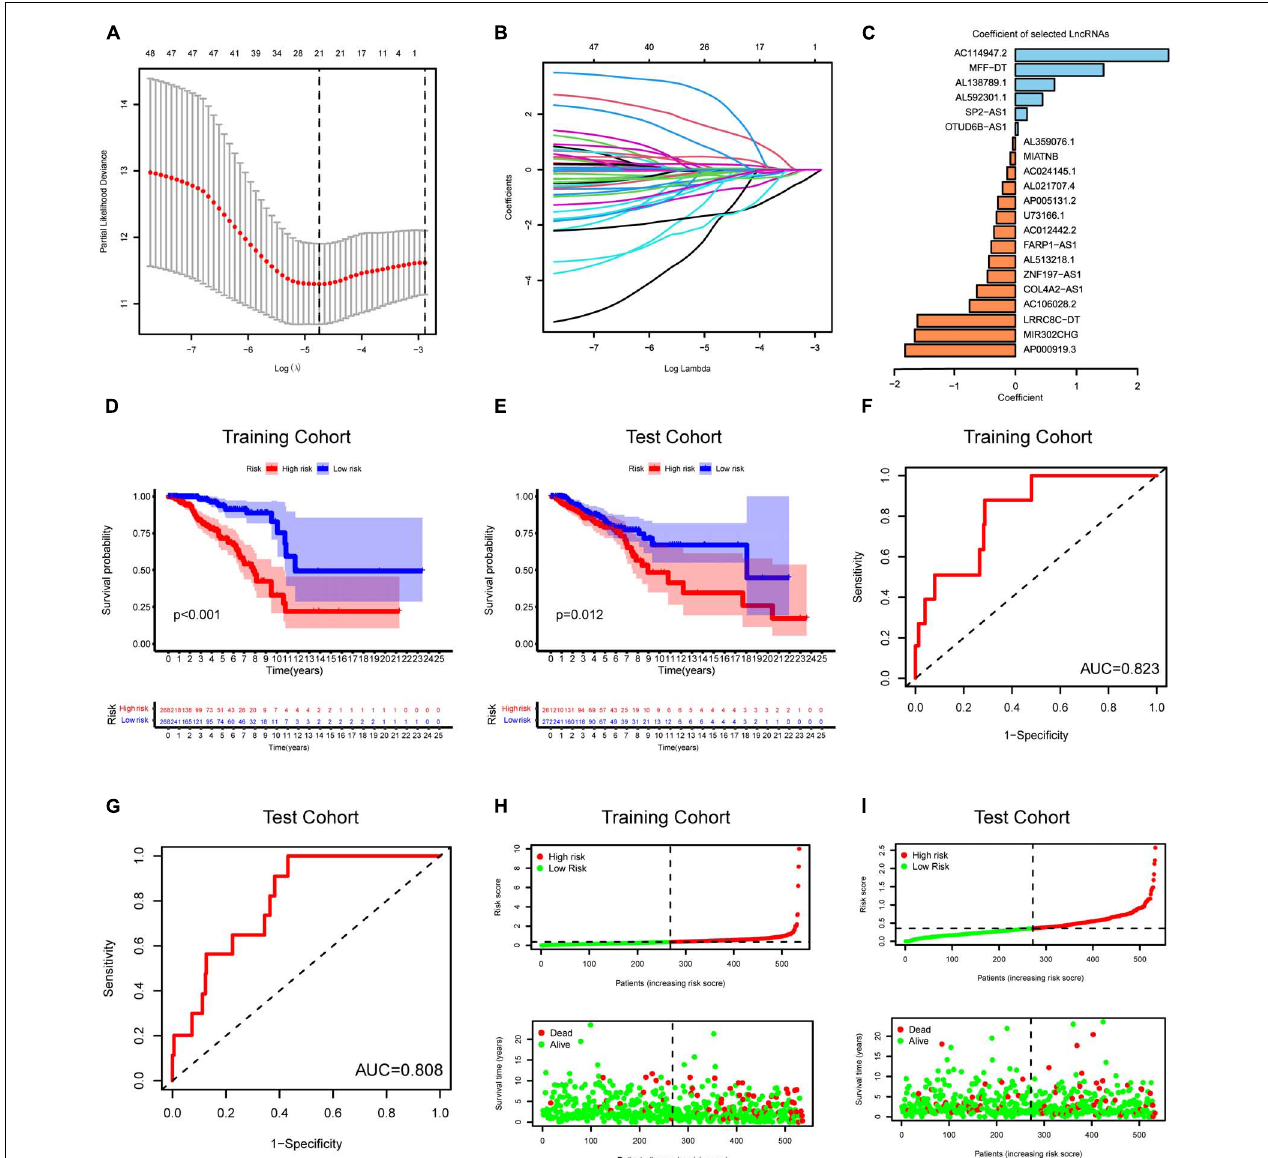
FIGURE 5 | Risk model from m6A-related lncRNAs. (A) Elucidation for LASSO coefficient profiles of prognostic m6A-related lncRNAs. (B) The least absolute shrinkage was performed and selection operator (LASSO) regression model for OS. (C) Bar plot displayed the coefficients of 21 selected m6A-related lncRNAs. (D,E) Kaplan–Meier curves for OS of TCGA-BRCA patients based on the risk stratification in the training cohort (D) and test cohort (E) . (F,G) ROC analysis for OS prediction of TCGA-BRCA patients in the training cohort (F) and test cohort (G) . (H,I) Distribution of risk score and OS status in the TCGA training cohort (H) and TCGA test cohort (I)